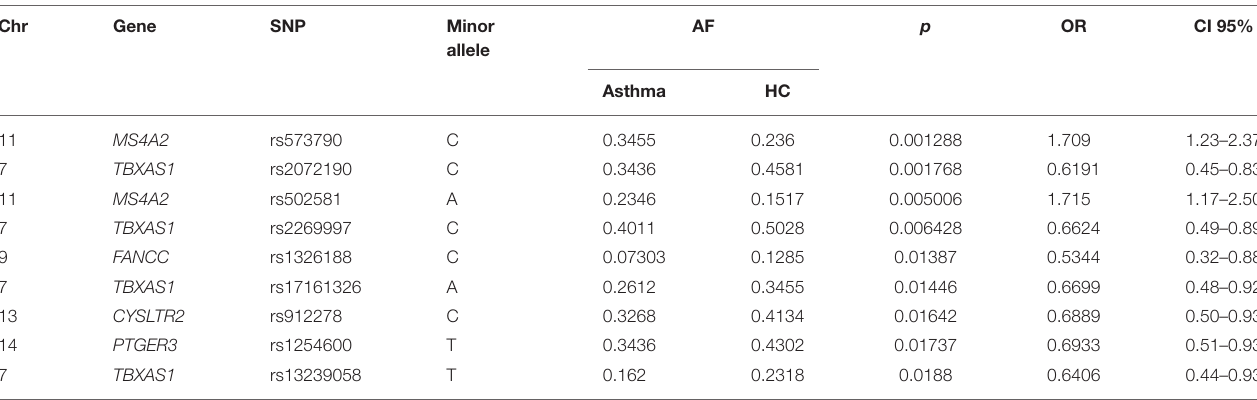
TABLE 4 | Allele frequency comparison between Asthma group vs. Healthy